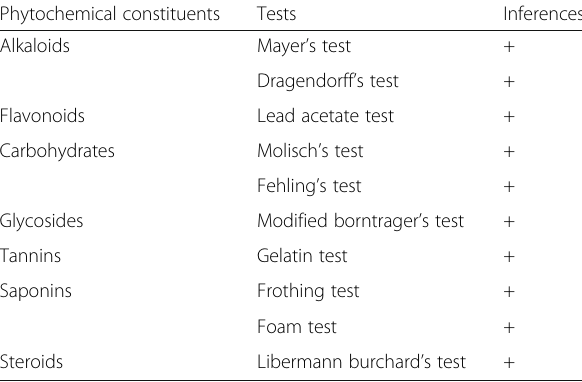
Table 1 Preliminary qualitative phytochemical screening of